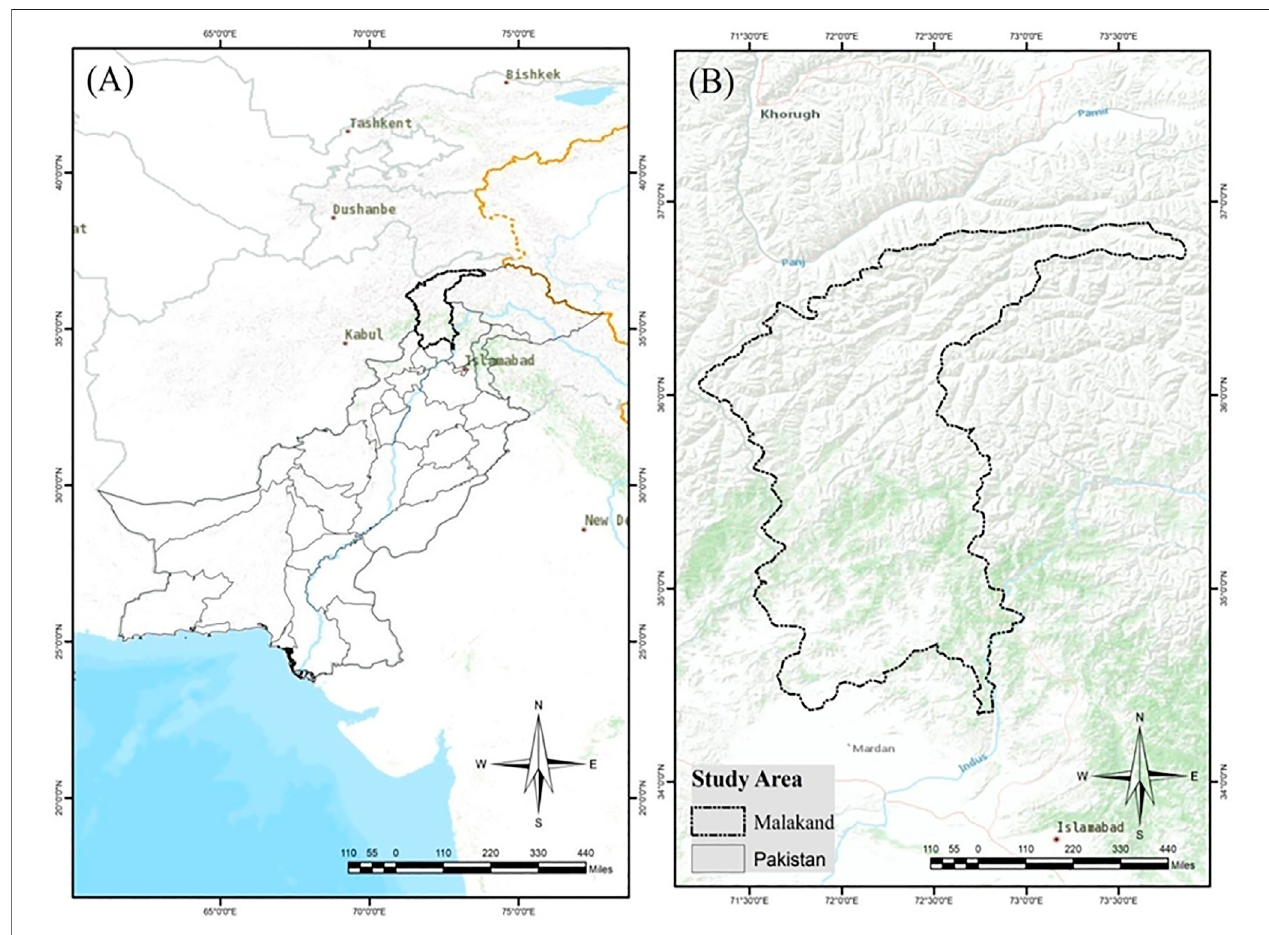
FIGURE 1 | (A) . Pakistan image. (B) . Study area